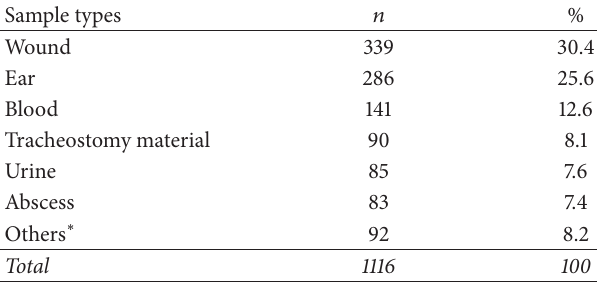
Table2:Distributionsof S.aureus strainsaccordingtosampletypes.